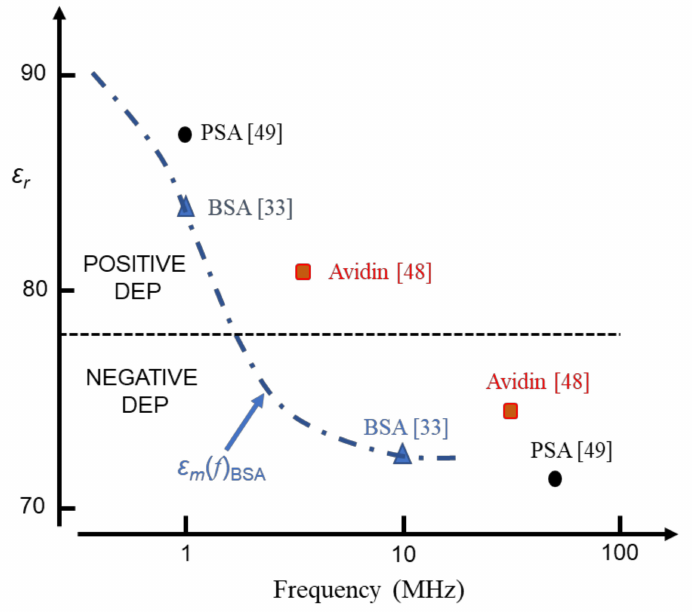
Figure 7. BSA, avidin and prostate specific antigen (PSA) have been reported to exhibit a DEP cross-over at MHz frequencies. This is consistent with the permittivity of the protein solution falling below the value ε r = 78 for pure water, as shown here for BSA (from data of Figure